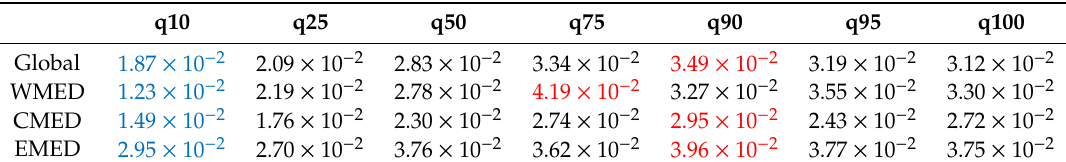
Table 1. Trend (in ◦ C / year) for di ff erent percentiles in the global, WMED, CMED and EMED basins. Blue / red values account for the lowest / highest tendency in every basin.